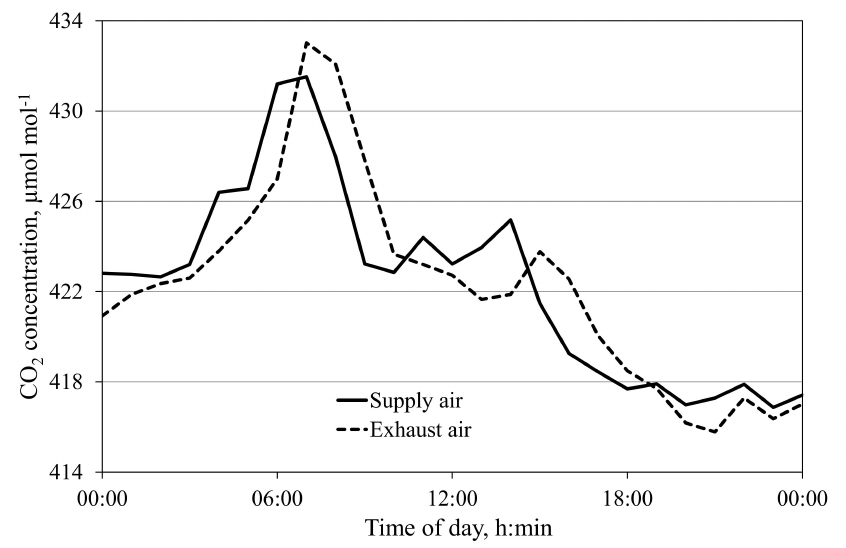
Figure 3. Daily time course of CO 2 concentration of the supply and exhaust air of an empty cabin at an air exchange rate of 3.5 m 3 h − 1 per m 2 cabin floor